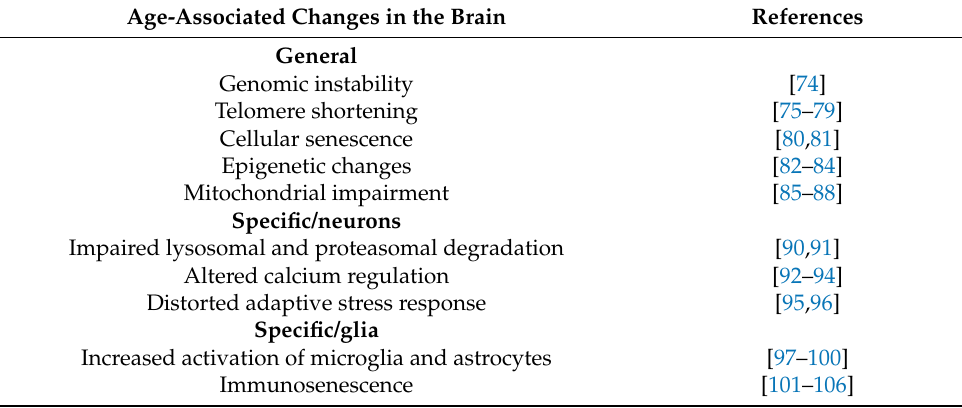
Table 2. Determinants of vulnerability in the aged